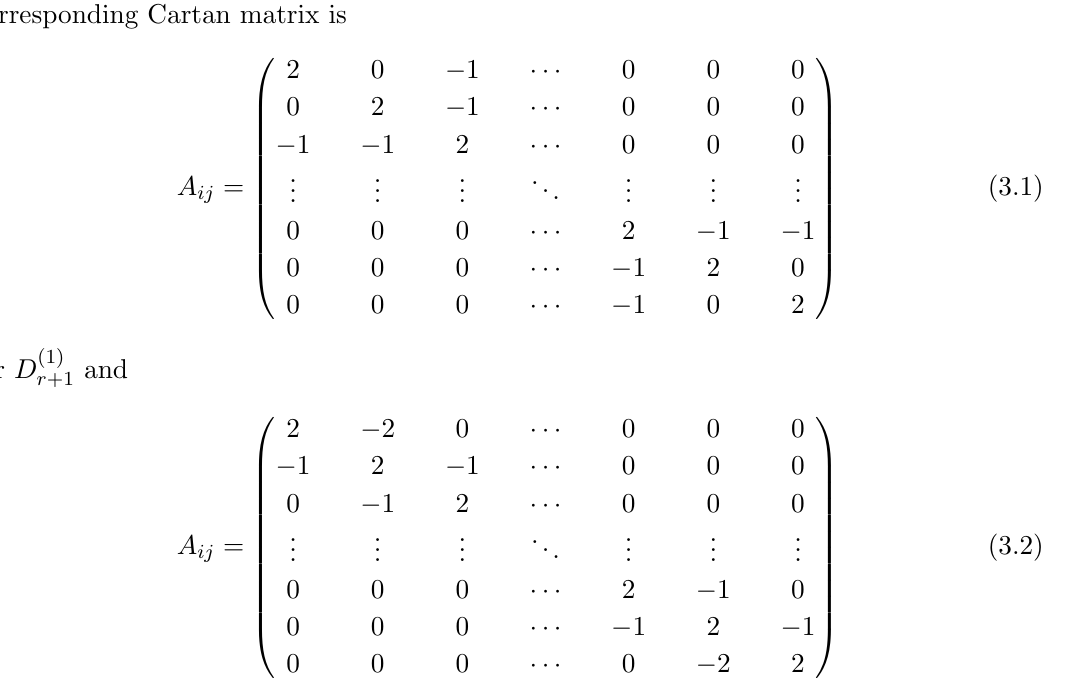
Figure 1 . Dynkin diagrams of B (1) Newton-Hooke